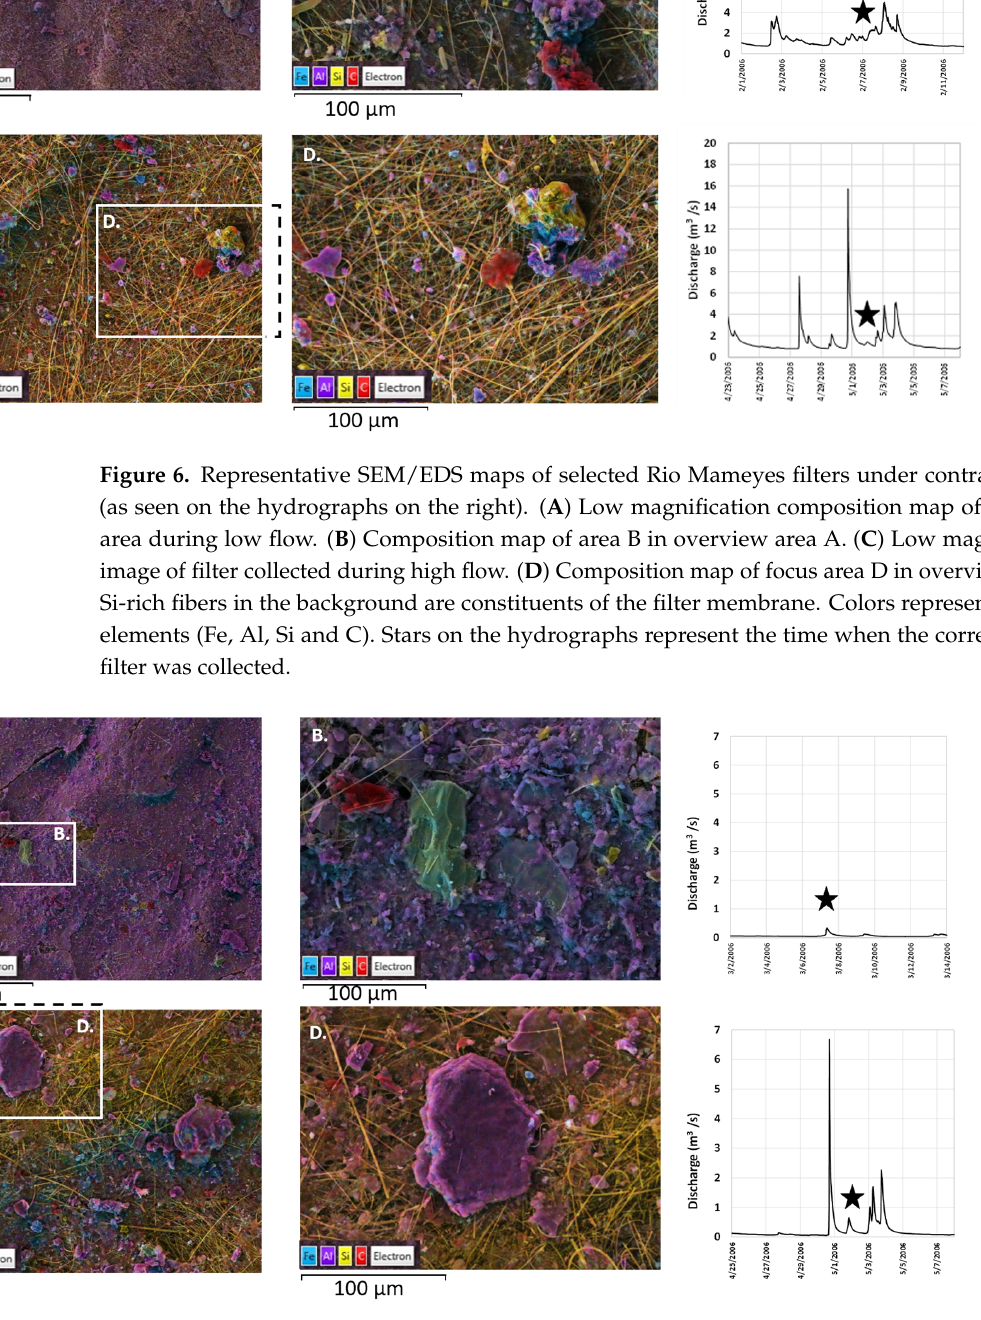
Figure 7. Representative SEM/EDS maps of selected Rio Icacos filters under contrasted flow (as seen on the hydrographs on the right). ( A ) Low magnification composition map of overview area during low flow. ( B ) Composition map of area B in overview area A. ( C ) Low magnification image of filter collected during high flow. ( D ) Composition map of focus area D in overview area C. Si-rich fibers in the background are constituents of the filter membrane. Colors represent selected elements (Fe, Al, Si and C). Stars on the hydrographs represent the time when the corresponding filter was